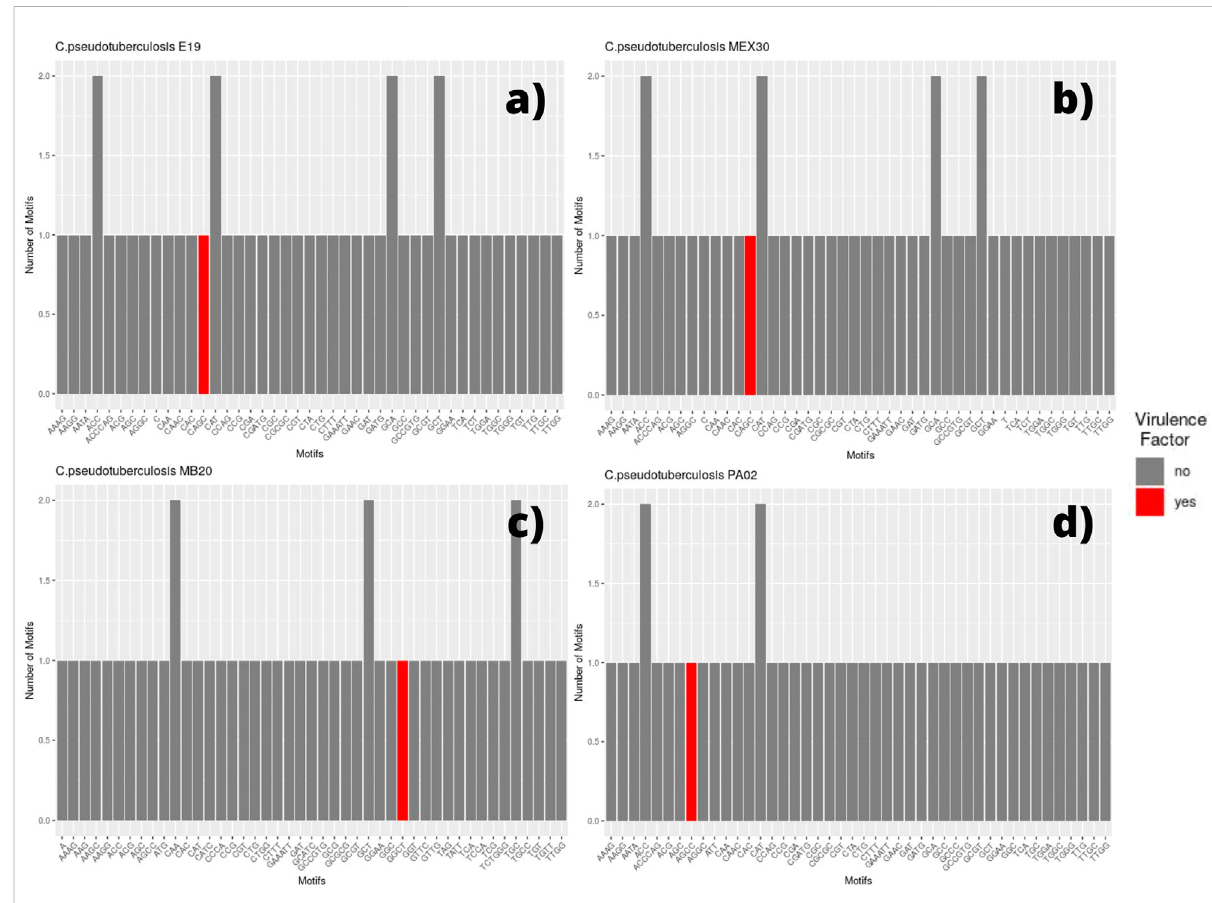
FIGURE 3 Bar graph showing the number of different SSR motifs observed in Corynebacterium pseudotuberculosis strains. In order, strain E19 (A) ; strain MEX 30 (B) ; strain MB20, in which the microsatellite with a GGCT motif occurs within a virulence factor located on the direct ribbon (C) ; and strain PA02, in which the microsatellite with an AGCC motif occurs within a virulence factor located on the reverse ribbon (D)